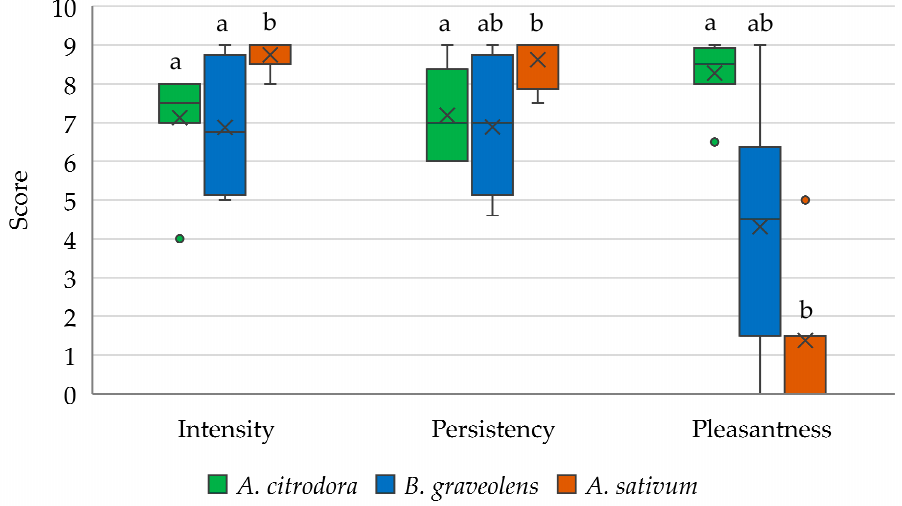
Figure 1. Scores attributed by the expert panel to the main hedonic parameters describing the Aloysia citrodora, Bursera graveolens , and Allium sativum essential oils (EOs). The box plots show the distribution of scores from the 25th to the 75th percentile. In each box, the middle line represents the median value, the x represents the mean value, the upper and lower vertical lines represent the maximum and minimum values, respectively, and the filled circles represent the outliers. Different letters indicate significant differences according to Dunn-Bonferroni pairwise comparisons test ( p ≤ 0.05). The EOs differed significantly in all of the analysed hedonic parameters ( χ 2 = 10.1, p = 0.06; χ 2 = 7.4, p = 0.025; χ 2 = 14.5, p = 0.001 for intensity, persistence, and pleasantness,